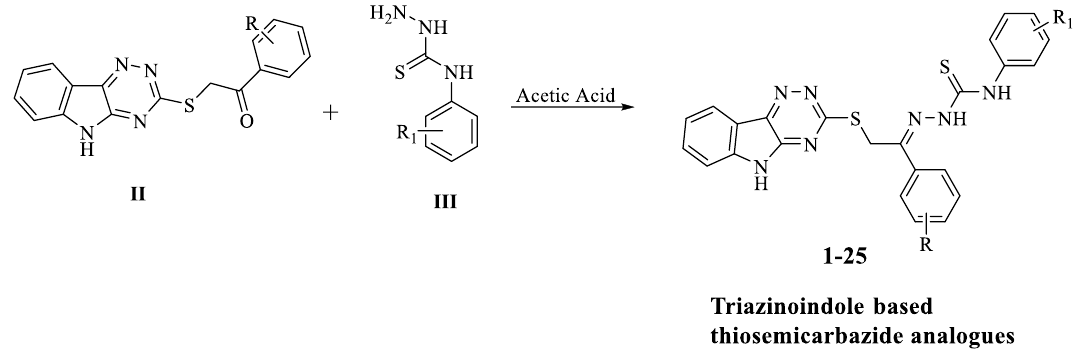
Scheme 2. Synthesis of thiosemicarbazide derivatives.